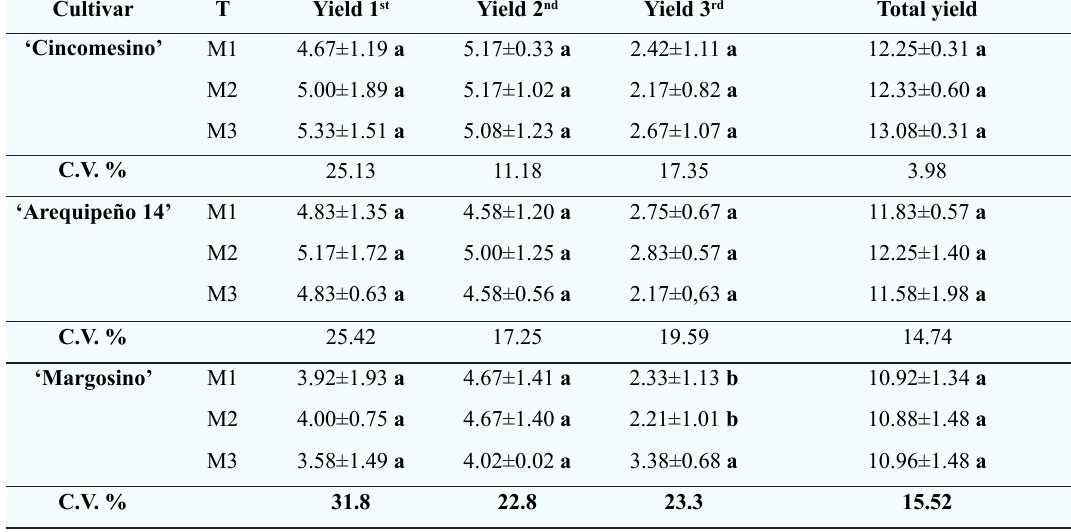
Table 2. Effects of different methods of fertilisation on the yield (t/ha) of three garlic cultivars: ‘Cincomesino’, ‘Arequipeño 14’